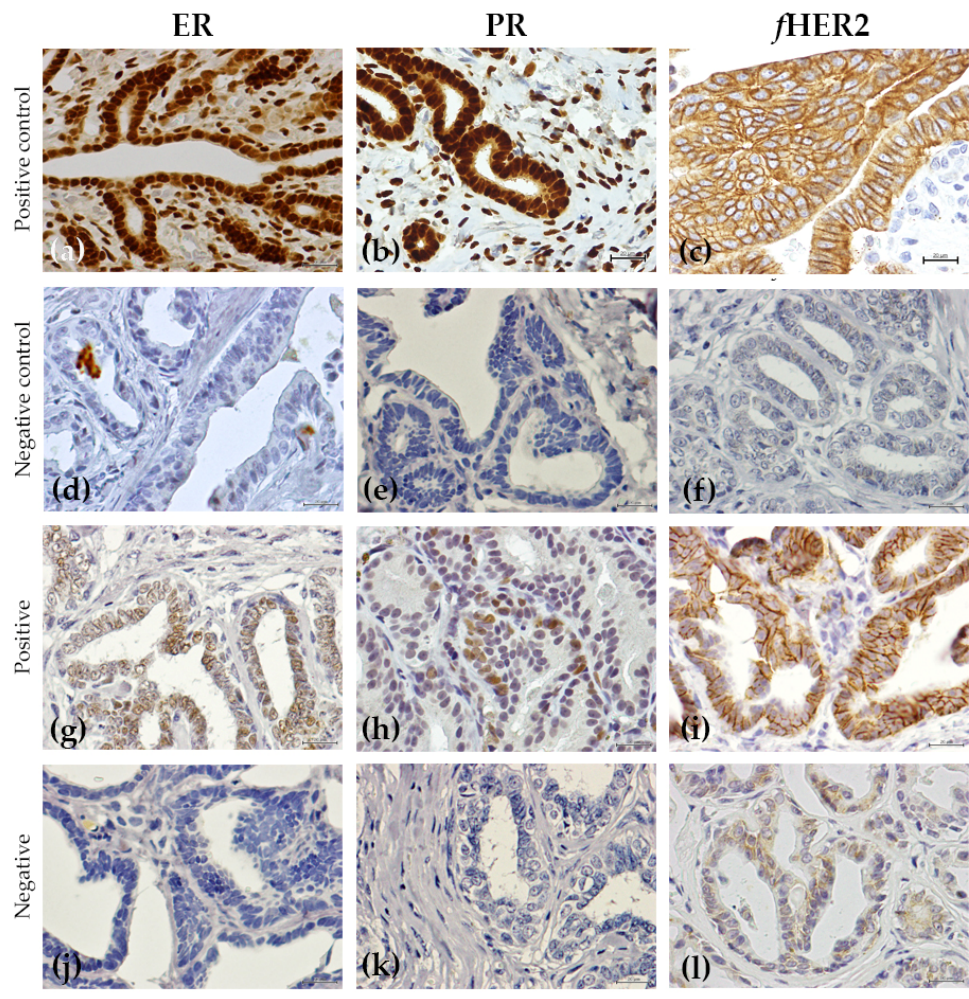
Figure 1. Immunohistochemical expression of the different proteins studied in non-neoplastic benign tumors and in benign tumors: ( a – c ) positive controls for ER, PR and f HER2, respectively; ( d – f ), negative controls for ER, PR and f HER2, respectively; ( g ) fibroadenomatous change with a positive score for ER (Allred score 7/8); ( h ) simple adenoma with a positive score for PR (Allred score 4/8); ( i ) simple adenoma classified as positive for f HER2 (3+) and ( j ) as negative for ER; ( k ) fibroadenomatous change with a negative score for PR and; ( l ) a simple adenoma classified as negative for f HER2 (0). All IHC were counterstained with Mayer’s hematoxylin (400×).